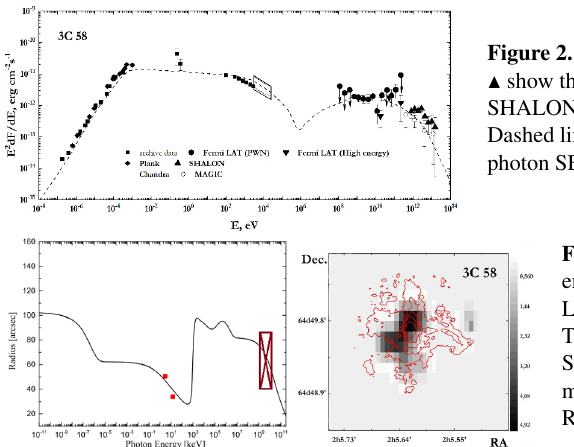
Figure 2. Spectral energy distribution of 3C 58. ▲ show the average spectrum from the SHALON data. Dashed line presents the modelling results of the photon SED with the parameters found in [25].